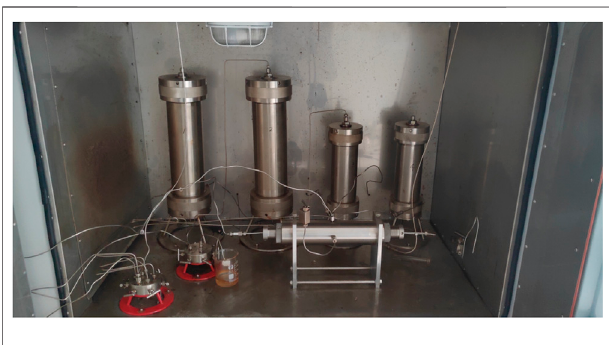
FIGURE 1 | Core test tool.